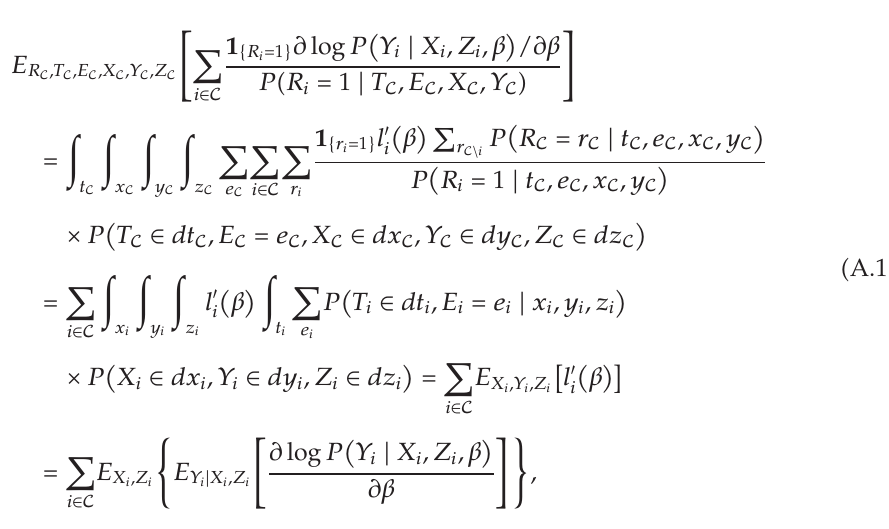
Figure 9: Sampling distributions for maximum likelihood estimates of regression coe ffi cient β 1 from 1000 replications; normal model fitted to gamma data (cid:5) Y i ∼ Z i (cid:9) Gamma (cid:5) 4 , 1 (cid:6)(cid:6) . be the correct data generating mechanism. This